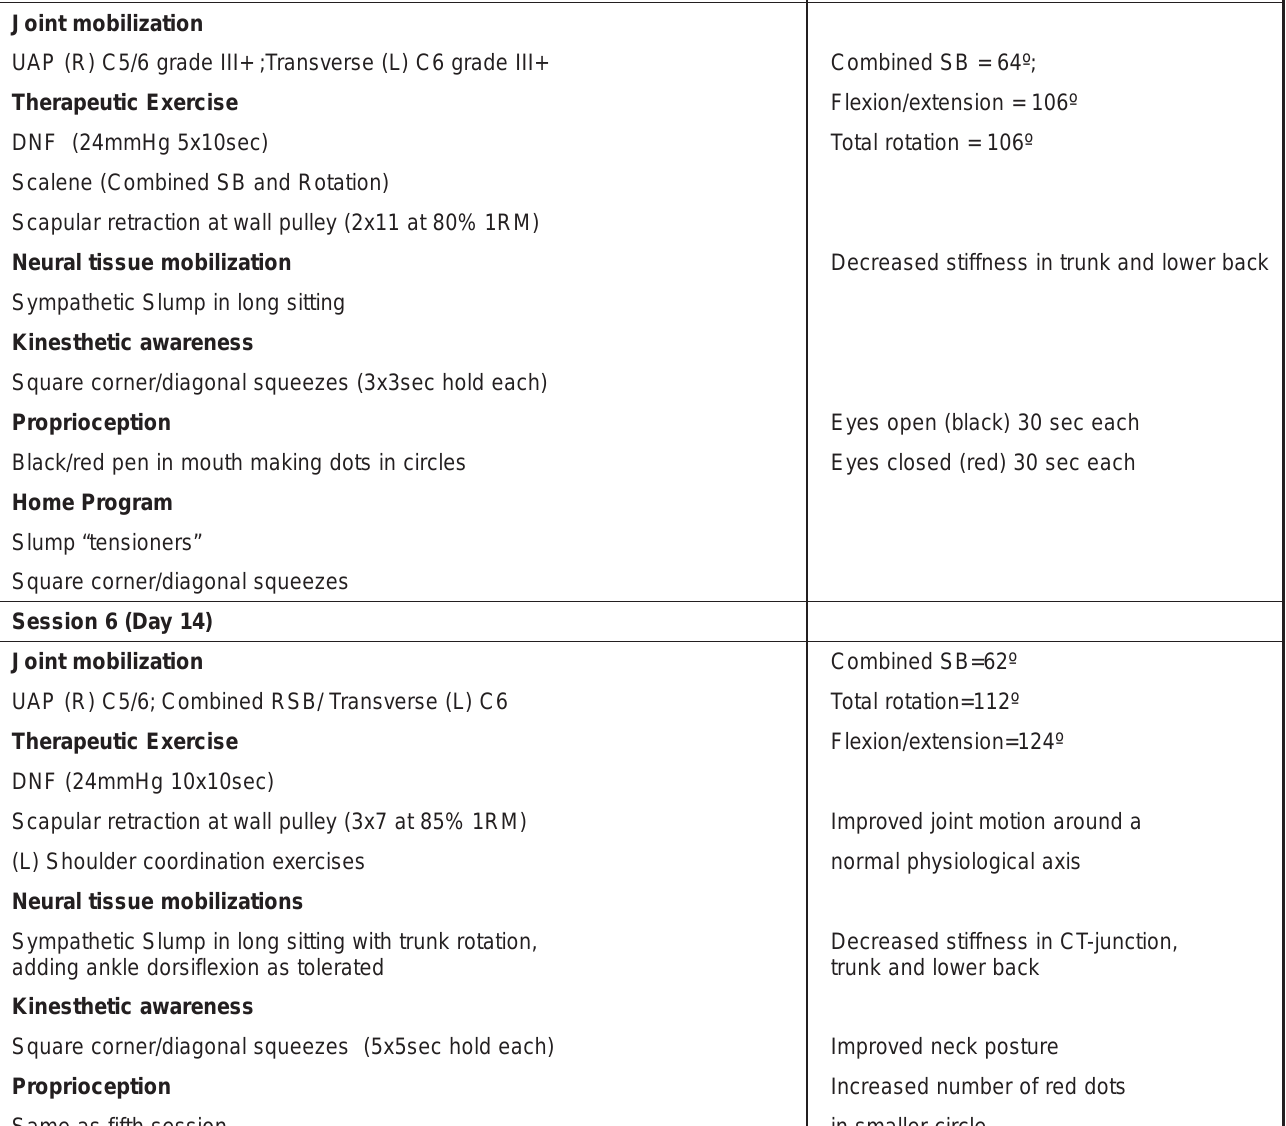
Table 1: Physiotherapy intervention and each sessions’ outcome in session one through six. Session 5 (Day 13)